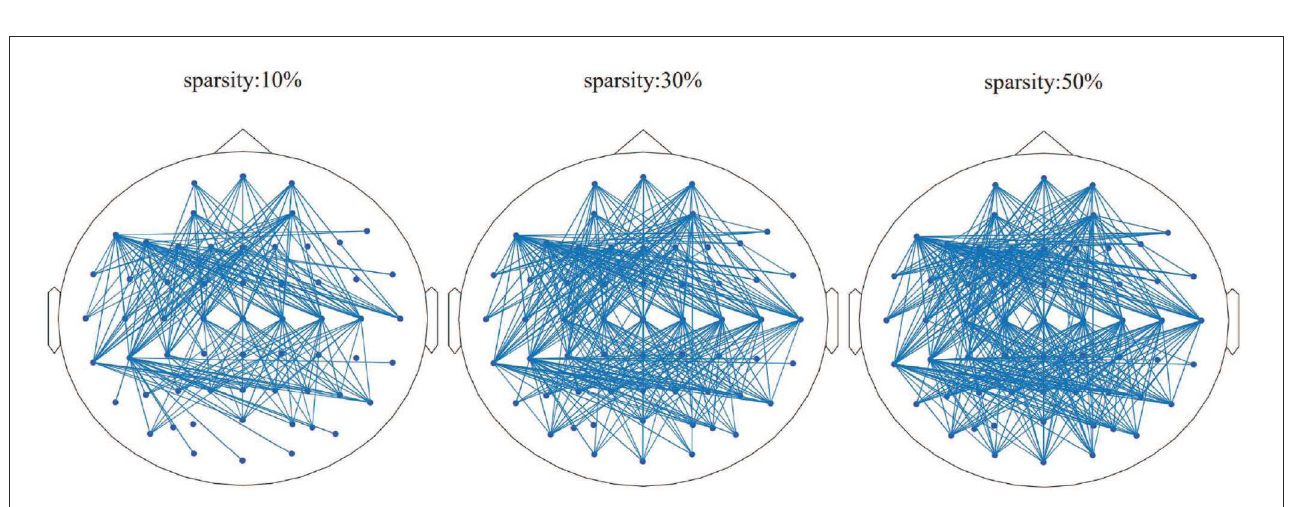
FIGURE5 Brain network results in different sparsity situations, as 10, 30, and 50 % , respectively.